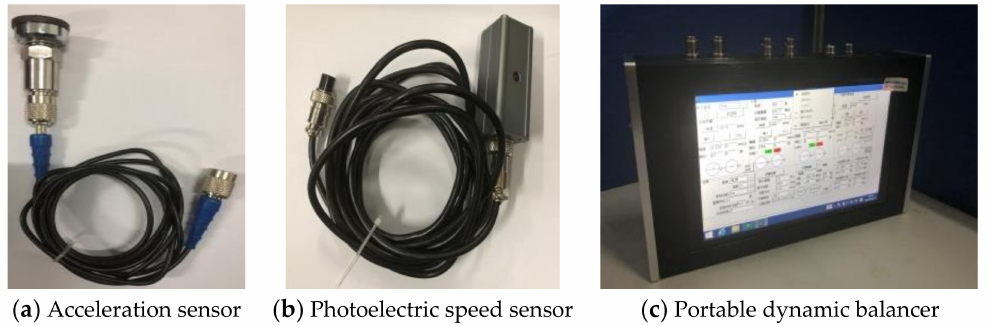
Figure 6. S956Y-1 Portable dynamic balancer.